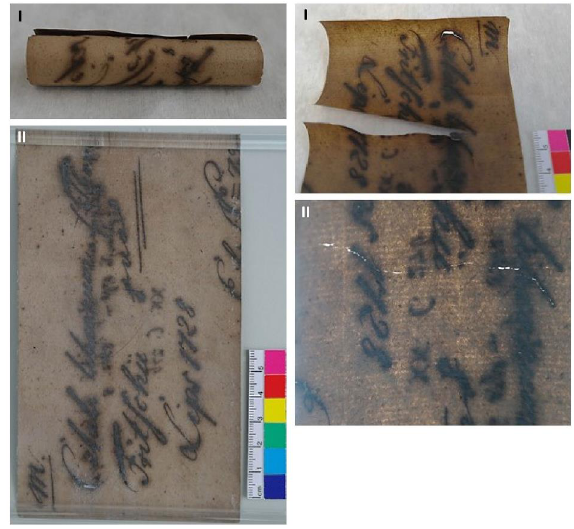
Figure 13. Sample of damaged paper before ( I ) and after ( II ) mechanical stabilization by CNF. After the application of CNF, the fractures and cracks were stabilized. Reproduced under terms of